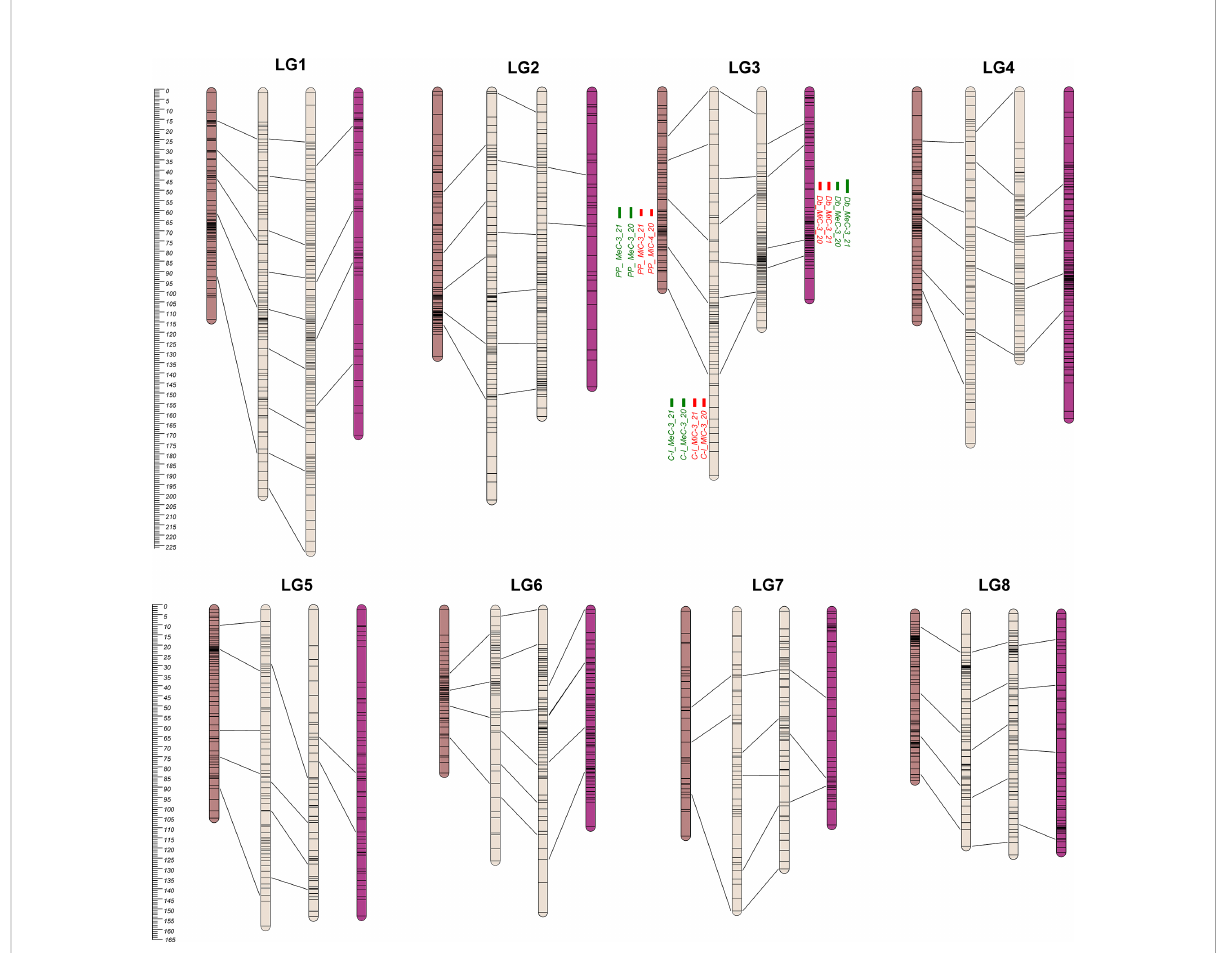
FIGURE 2 From the left to the right: PP, C-I, C-II, and Db Linkage Groups. Eight LGs (corresponding to the haploid chromosome number of the species) were identi fi ed within each parental map. C-I map was the bigger one, covering 1,305.8 cM, while the PP map was the smaller one with 829.8 cM (Table 1). QTL regions are reported as green (MeC) and red (MiC) bars on the right side of the associated